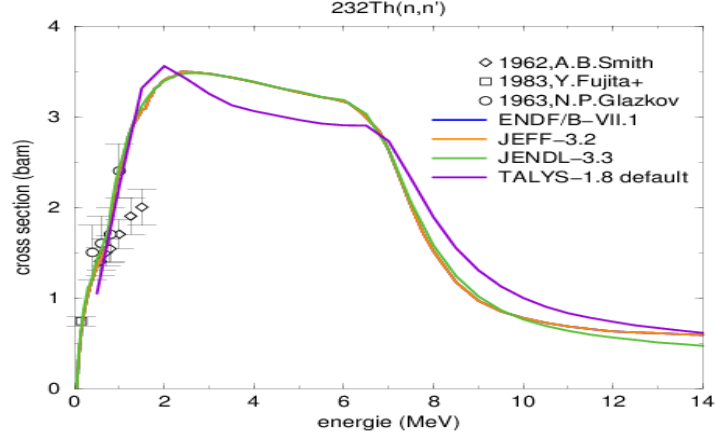
Figure 1. (color online) Previous experimental and evaluated data of the total inelastic neutron scatter- ing cross section of 232